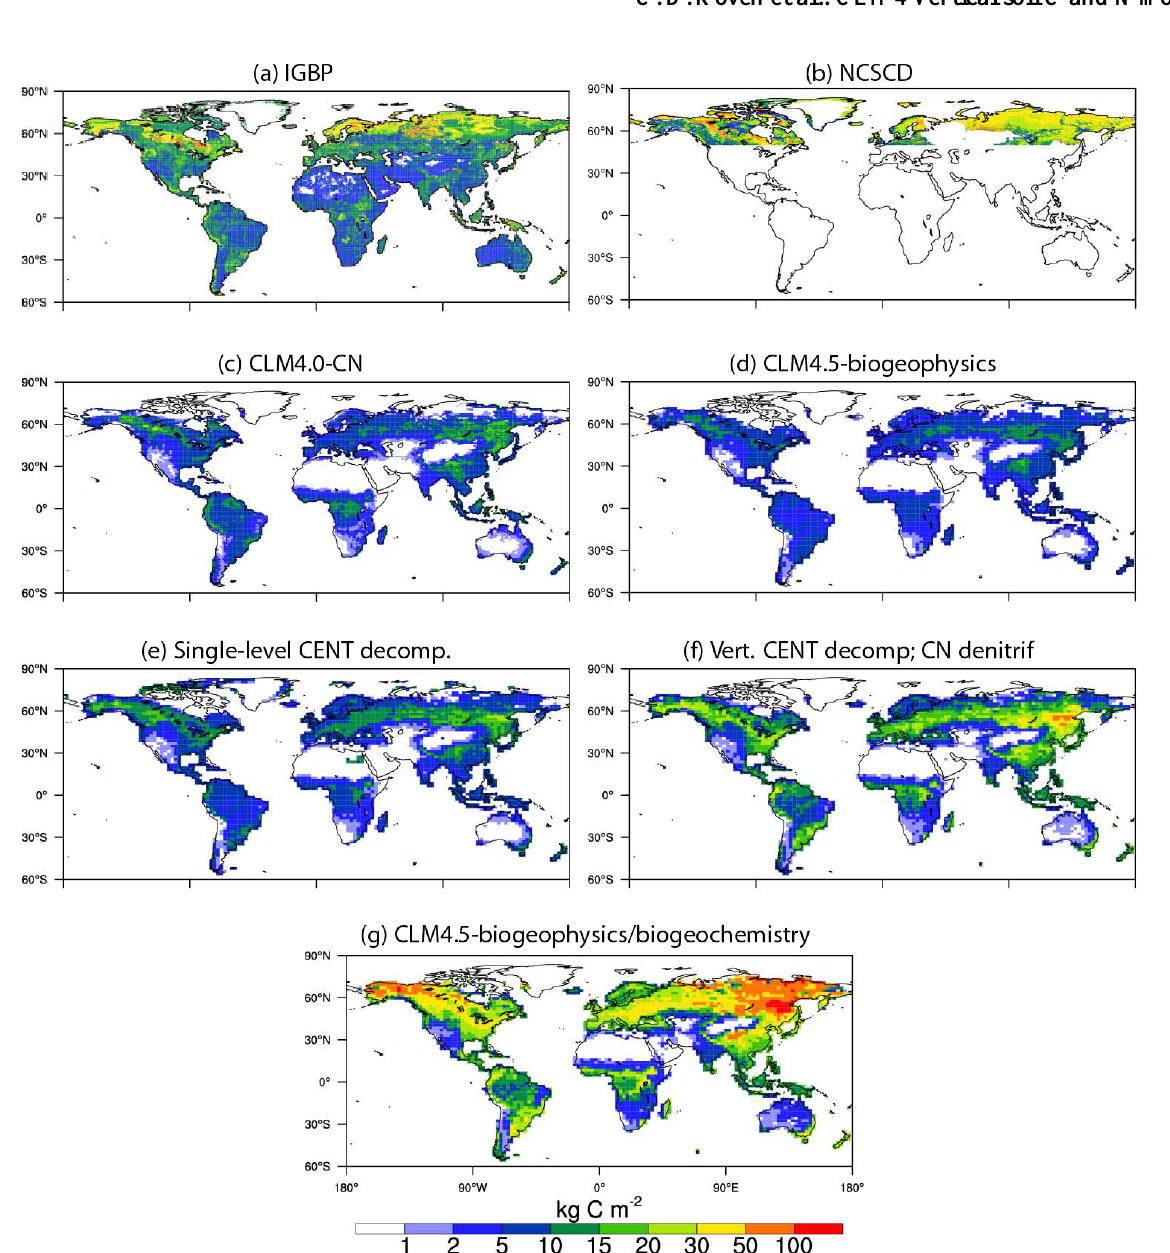
Fig. 5. Maps of soil C. (a, b) Observed soil C databases: (a) IGBP-DIS dataset (Global Soil Data Task Group, 2000); (b) NCSCD, (Tarnocai et al., 2007; Hugelius et al., 2013). (c–g) Modeled soil C for various cases: (c) base CLM4.0-CN; (d) CLM4.5-biogeophysics; (e) single-level biogeochemistry (BGC), Century-based decomposition; (f) multi-level BGC, Century-based decomposition, C N denitrification; (g) multi- level BGC, Century-based decomposition and nitrification/denitrification (CLM4.5-biogeophysics/biogeochemistry). For observations and multi-level model, data here is for upper 1m of soil. Note quasi-logarithmic scale